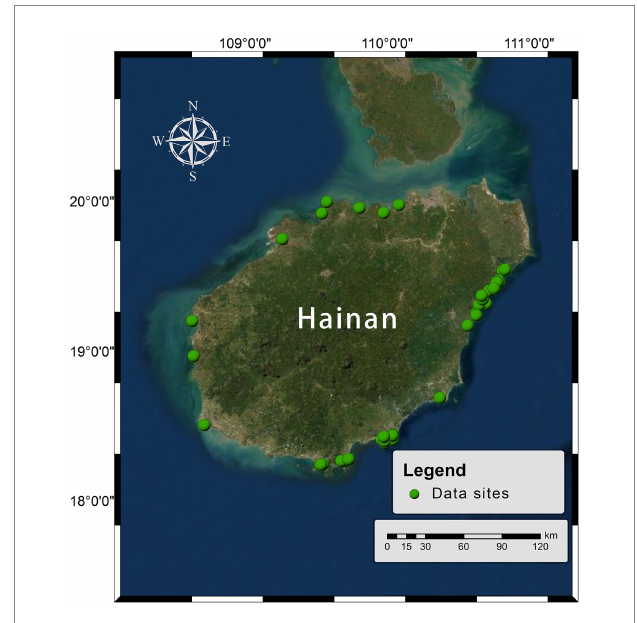
FIGURE 1 Study area and seagrass field distribution location